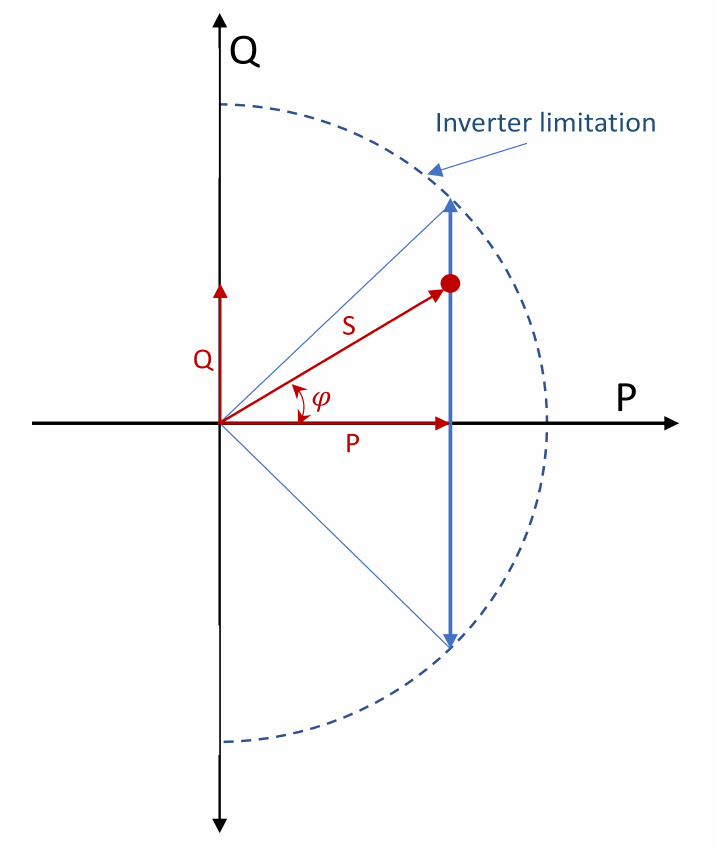
Figure 1. Inverter operative